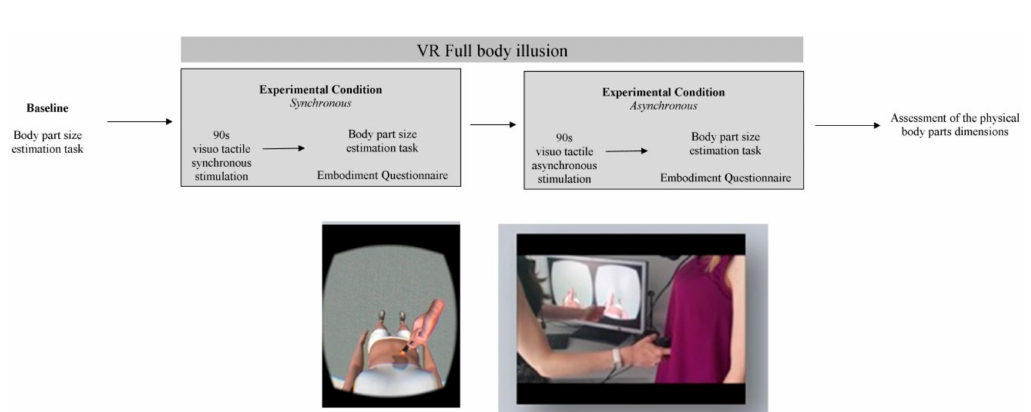
Figure 1. Graphical representation of the VR experimental time-line (upper part) and set-up (below